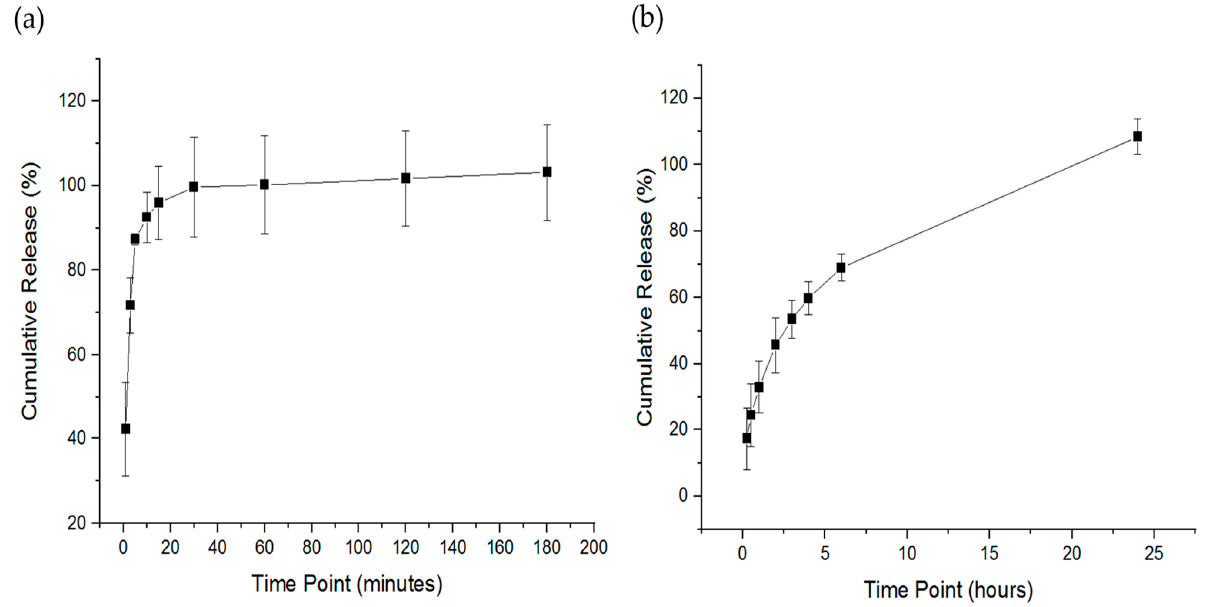
Figure 5. The release profile of the imeglimin-loaded nanofibers. The drug release profile of the thermo-shaking incubator method ( a ) showed a burst release at 1 min and a full drug release after 30 min. The drug release profile of the Franz diffusion method ( b ) showed a sustained release of imeglimin from approximately up to 6 h and a complete drug release after 24 h. The results are presented as the mean ± SD (n =